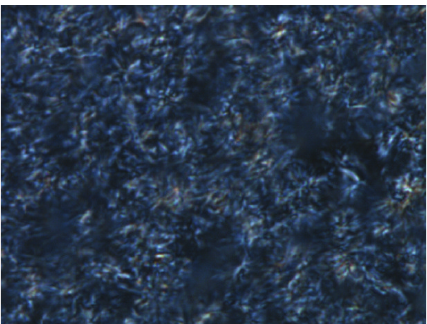
Figure 6: Optical image of PCL after 3600 seconds of isothermal crystallization (hot stage temperature = 45 ∘ C), 50x (image dimen- sions: 175 × 131.2 𝜇 m).